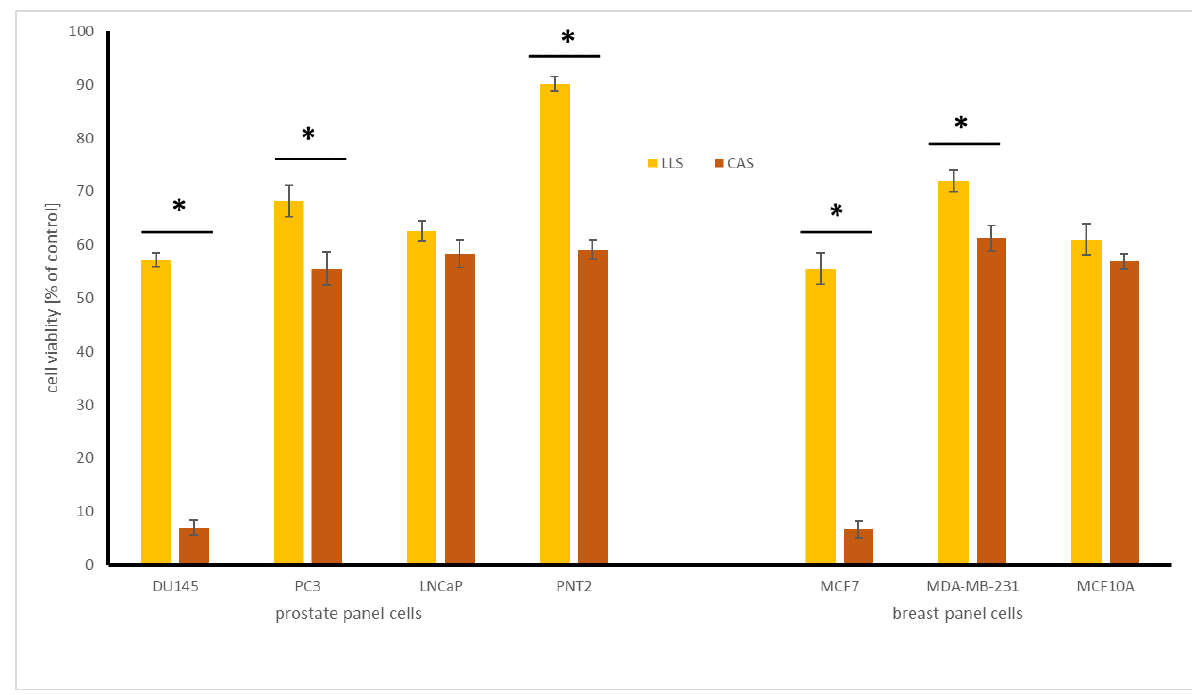
Figure 1. Cytotoxic effect of lupin (LLS) and chickpea (CAS) seed extracts on prostate and breast normal and cancer cells (for the acronyms of the cell lines – see Section 2.5). Cells were treated with 500 µg/mL of seed extracts (n = 3) for 24 h. Values are presented as the mean ± SD (standard deviation). Significant differences between two kinds of seeds ( p < 0.05) were marked with *. Table 1. Content (mg/100 g dw) of individual isoflavones and their sums in chickpea sprouts (CA) harvested in different LED light conditions for 3, 5, 7, and 10 days (mean ± SD; n =